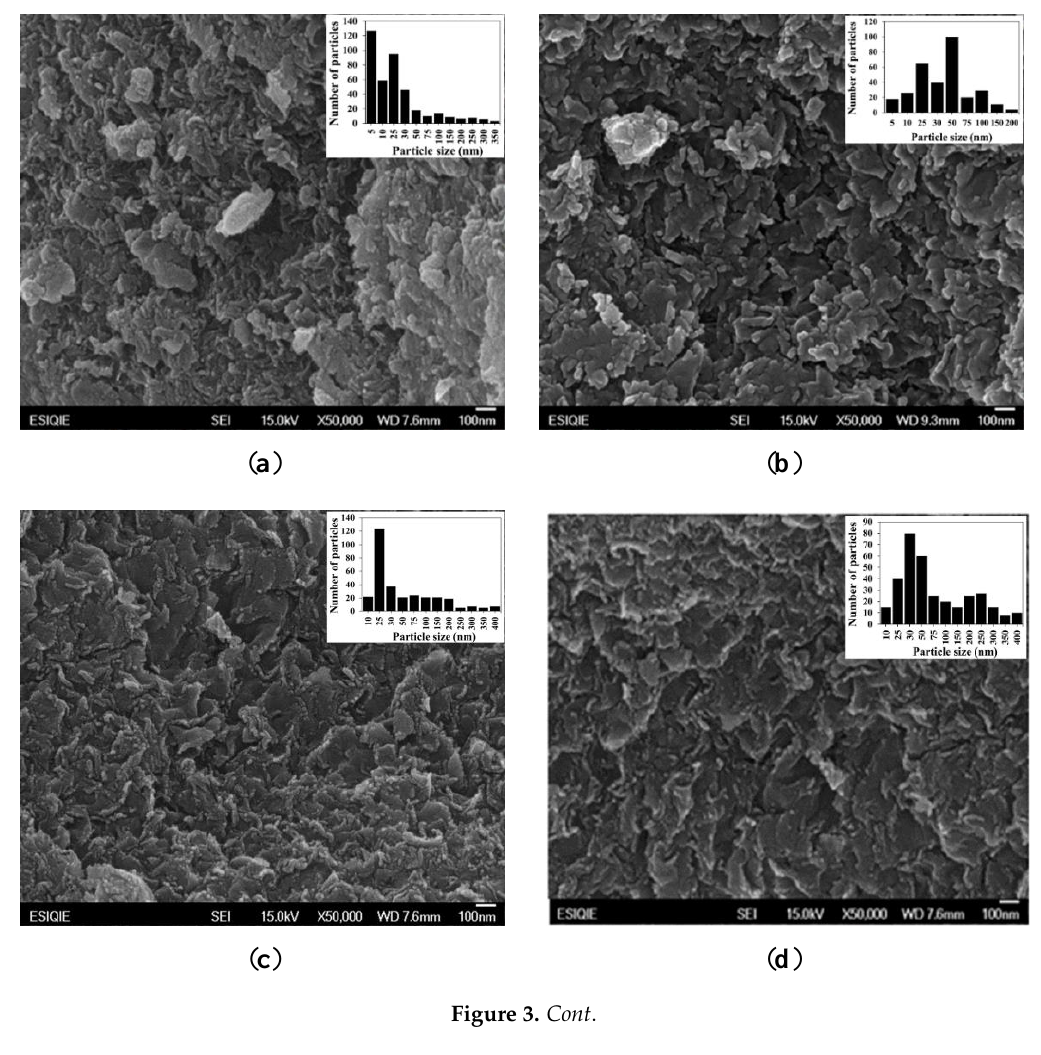
Figure 2. X-ray diffraction patterns of oxides calcined at 550 °C: ( a ) 100A, ( b ) 5SA, ( c ) 15SA, ( d ) 25SA y ( e ) 100S.